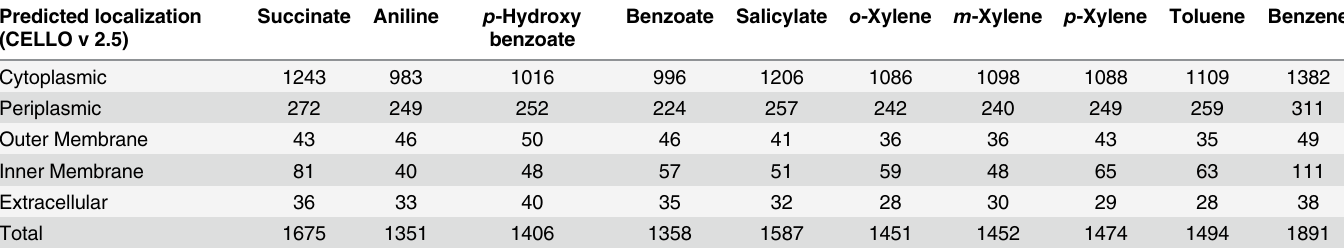
Table 2. Summary of proteomic results of Burkholderia sp. K24 cultured in different aromatic hydrocarbons. Predicted localization (CELLO v